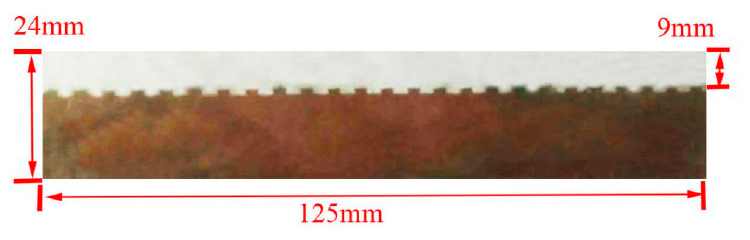
Figure 3. The physical cross-section of the hot-melt explosive composite plate.